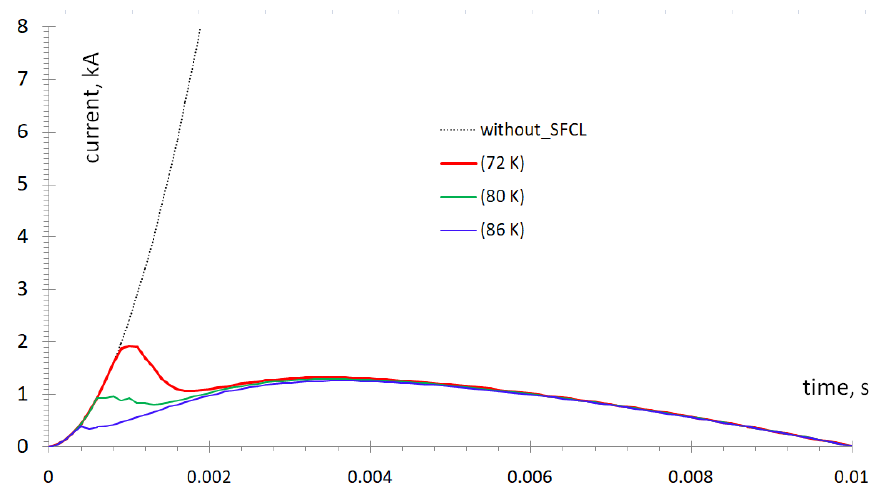
Figure 10. Currents in the short-circuit circuit with a limiter (SFCL) placed in it, cooled to 72 K, 80 K and 86 K, and in the circuit without the limiter (without_SFCL). Time from 0 s to 0.01 s (numerical analysis).